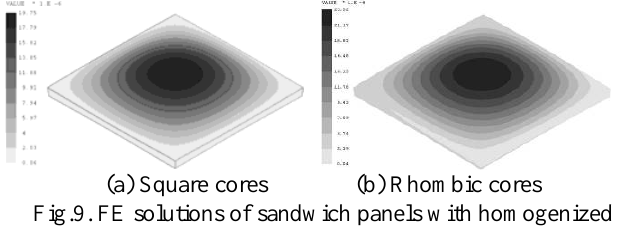
Fig.9. FE solutions of sandwich panels with homogenized cores